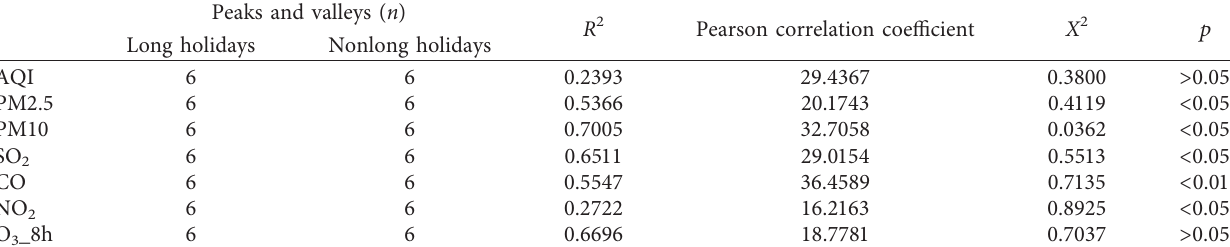
Table 5: Pearson correlation analysis of long holidays (Spring Festival and National Day) and nonlong